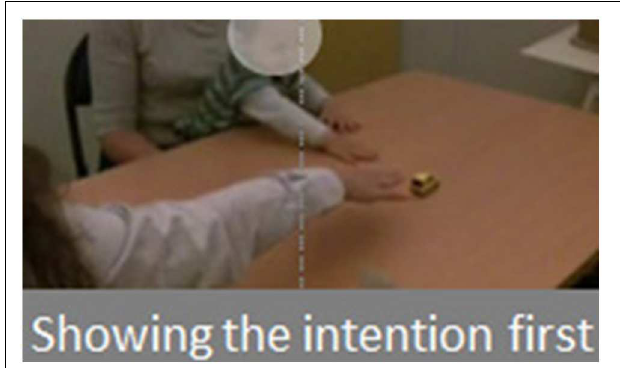
FIGURE 4 | Showing the intention prior to